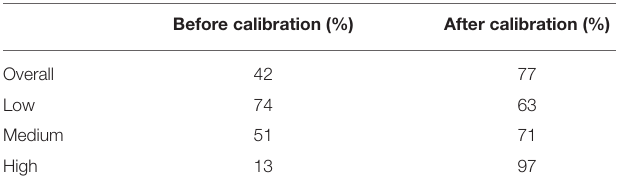
TABLE 2 | Summary of the DEX primary productivity model performance before and after